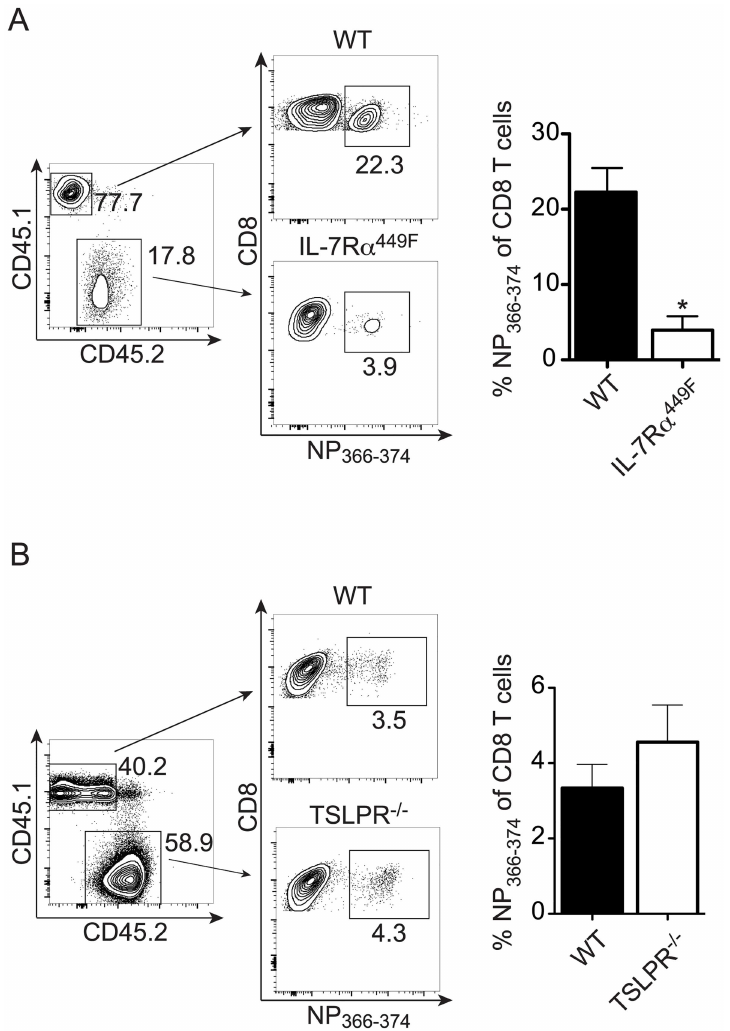
Fig 4. Cell-intrinsic requirement for IL-7R α , but not TSLPR, signaling in CD8 T cell response to Influenza A. LethallyirradiatedCD45.1 BoyJ mice were reconstituted with (A) 9:1 IL-7R α 449F :BoyJ or (B) 1:1 TSLPR -/- :BoyJ bone-marrow and allowedto recover for 6–8 weeks. Mice were infected with 5HAU of PR8 and the T cell responsewas analyzedat day 9 post-infection. CD8 T cells were stained for CD45.1and CD45.2 to identify WT or mutant derived cells. Each population was analyzedfor the percent of total CD8 T cells that recognize the NP 366–374 tetramer. Data shown is from one representative experiment of two experiments, n = 3–7. * p < 0.05by Student’s